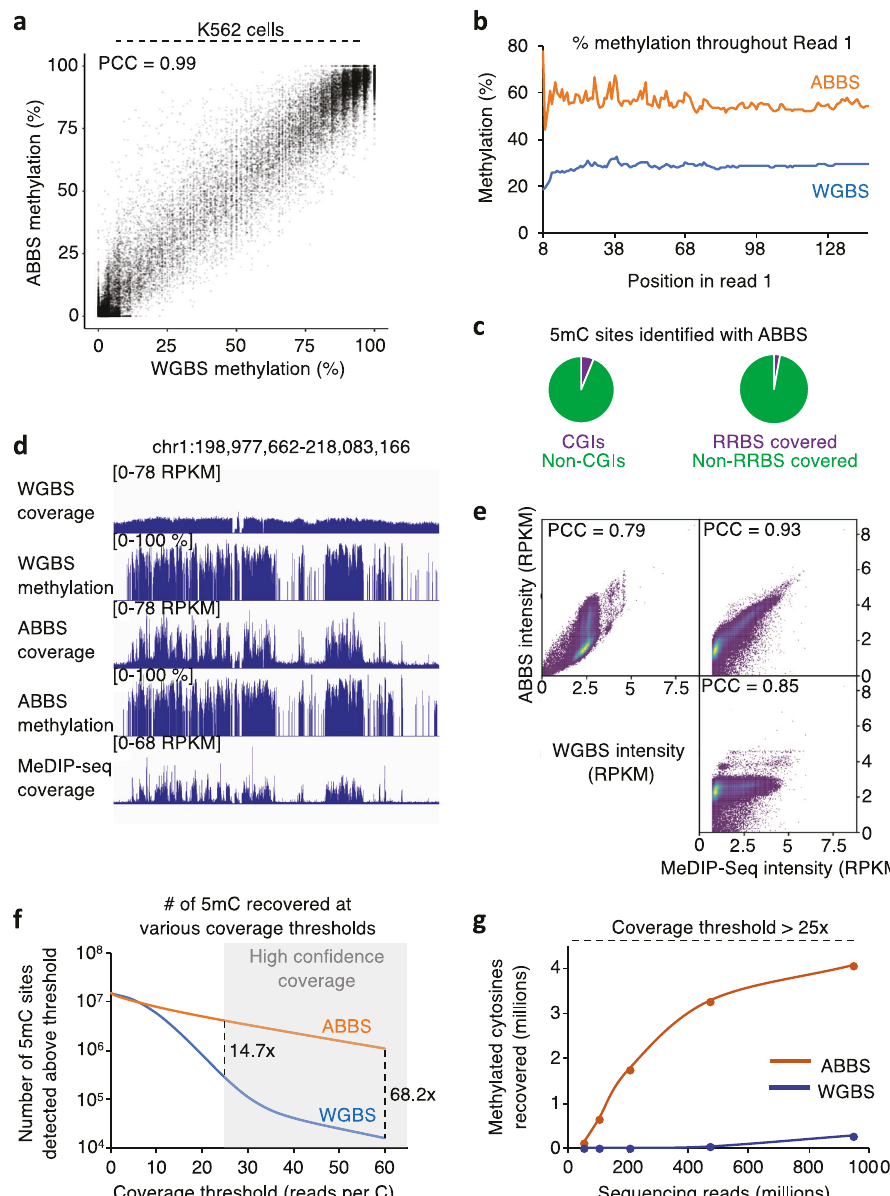
Fig. 2 ABBS detects 5mC in human K562 cells. a ABBS accurately measures cytosine methylation levels. Scatter plot of the methylation levels measured by WGBS and ABBS for all cytosines with a coverage over 25× in both samples. PCC, Pearson ’ s correlation coef fi cient with two-tailed P < 2.2 × 10 − 16 . b ABBS reads contain more 5mC than WGBS reads. The average prevalence of 5mC is shown for ABBS and WGBS at each position in read 1. c 5mC sites identi fi ed with ABBS are predominantly outside of CGIs and are not covered by RRBS. Shown are the fractions of 5mC sites identi fi ed with ABBS (100 million reads subsample, see methods) found inside or outside of CGIs (left), and covered or not covered by RRBS (right). d ABBS signals colocalize with MeDIP-seq coverage and with the presence of 5mC. Genome browser tracks show signal distributions for WGBS, ABBS, and MeDIP-seq, as well as methylation levels determined by WGBS and ABBS. e ABBS signals colocalize with MeDIP-seq but not WGBS. The coverages for WGBS, ABBS, and MeDIP-seq are compared for each 10-kb bin over the human genome. PCC, Pearson ’ s correlation coef fi cient with two-tailed P < 2.2× 10 − 16 . f ABBS offers increased coverage at 5mC sites, relative to WGBS. Shown are the absolute numbers of 5mC sites (>50% methylation) identi fi ed with ABBS (orange) and WGBS (blue), at varying coverage thresholds. g The sensitivity of ABBS surpasses that of WGBS for detection of 5mC. Shown are the absolute numbers of 5mC sites (>50% methylation) identi fi ed with ABBS (orange) and WGBS (blue), at varying total read counts and with a coverage threshold set at